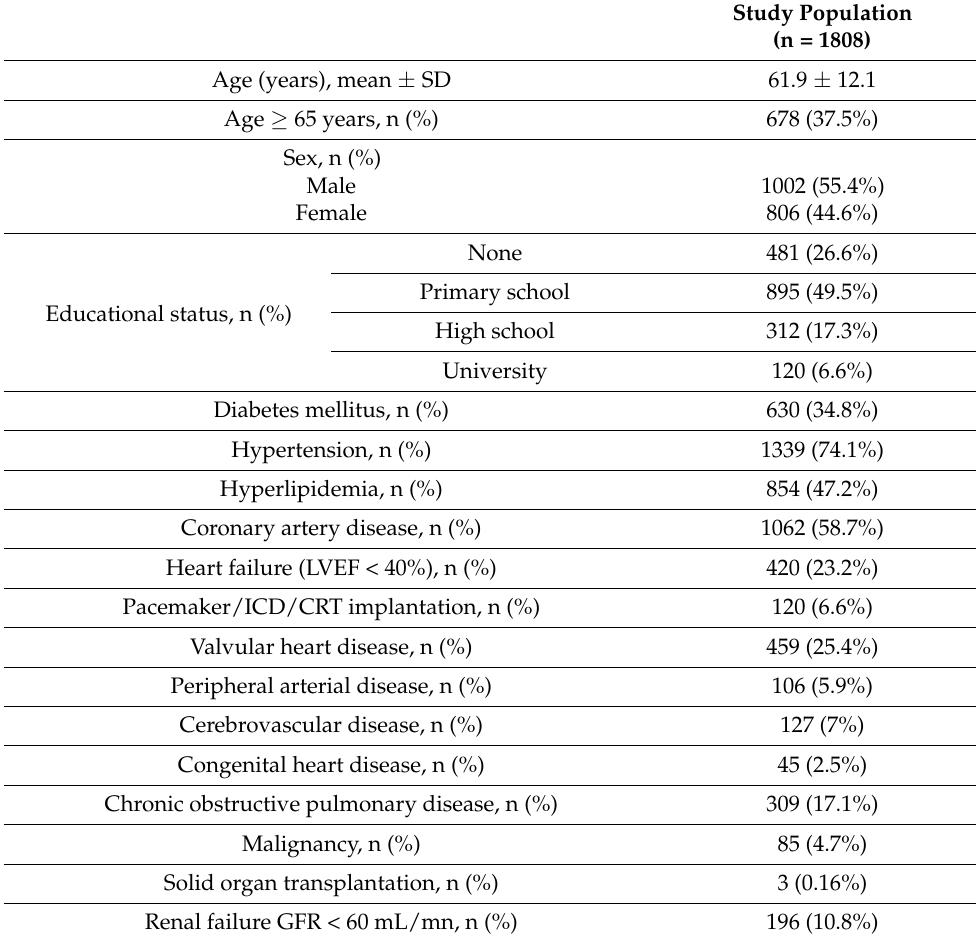
Table 1. Basic demographic and clinical characteristics of the patients.